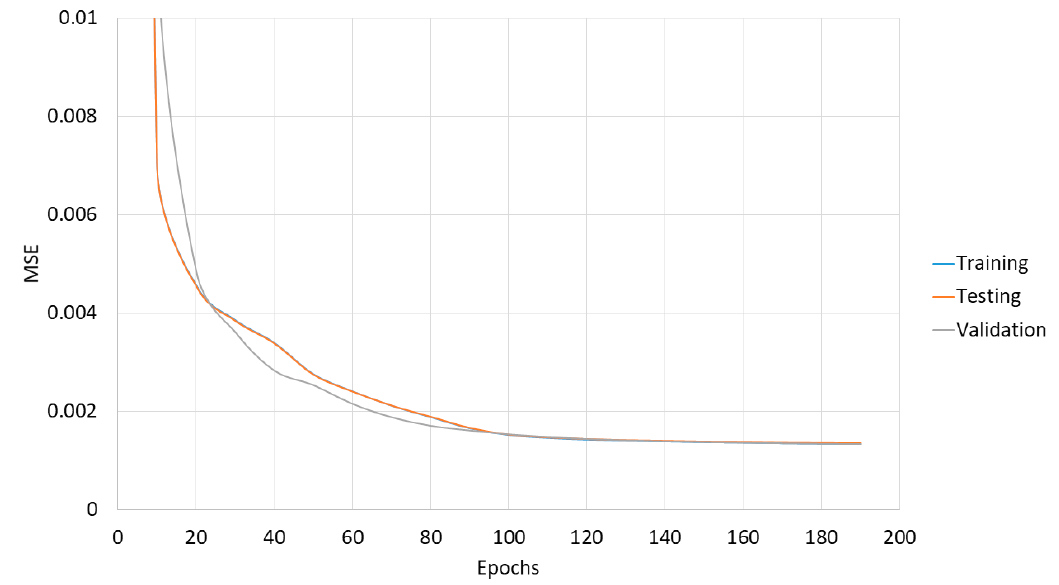
Figure 5. Variations of training, testing and validation mean square errors (MSEs) along 200 epochs in the designed deep learning configuration.